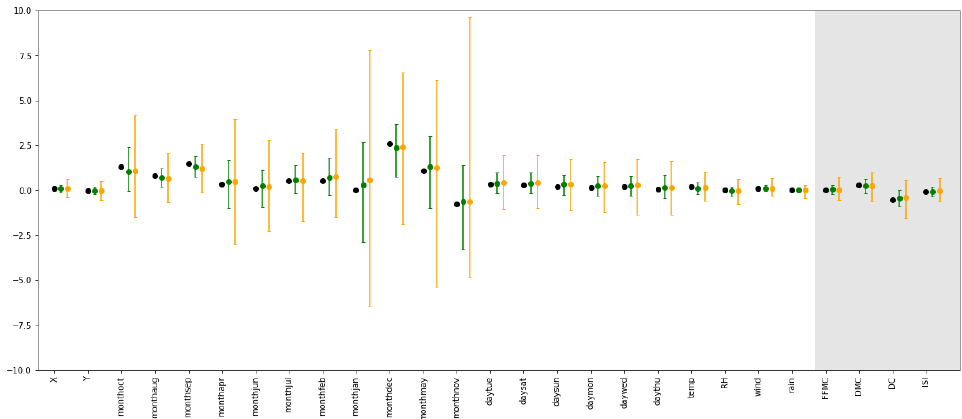
Figure 5. Centralized parameter estimates (black) for forest fire analysis, with average coefficients and 95% confidence intervals for ε = 1 (orange) and ε = 10 (green), for γ = 1.2, 1000 repetitions. Parties are separated with background